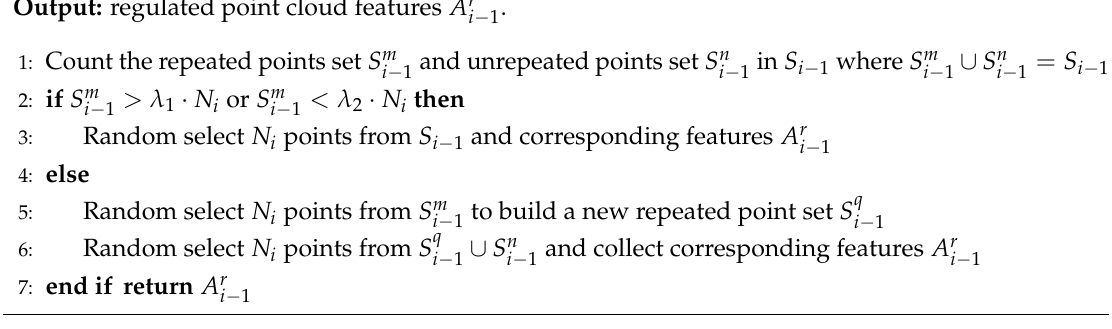
Algorithm 1 A regulation algorithm of CMF module to avoid over-saturation of repeated points in the points